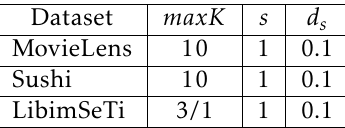
Table 3. Parameter setup for iCluster-NMF and